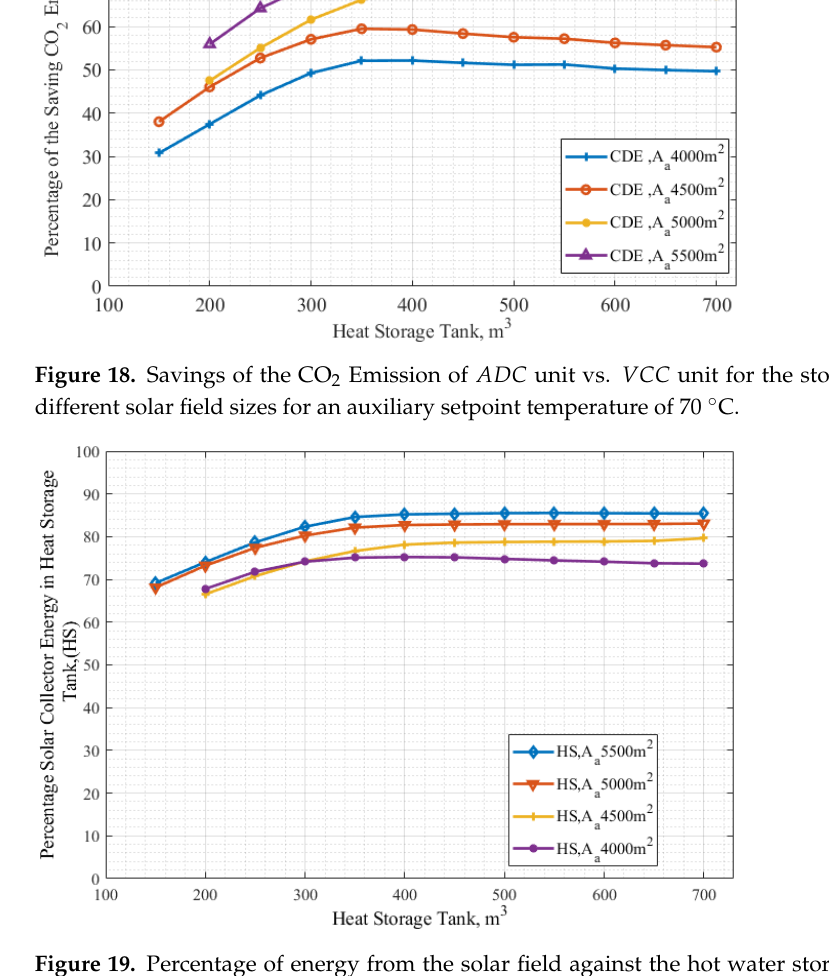
Figure 19. Percentage of energy from the solar field against the hot water storage volume for an auxiliary setpoint temperature of 70 ◦